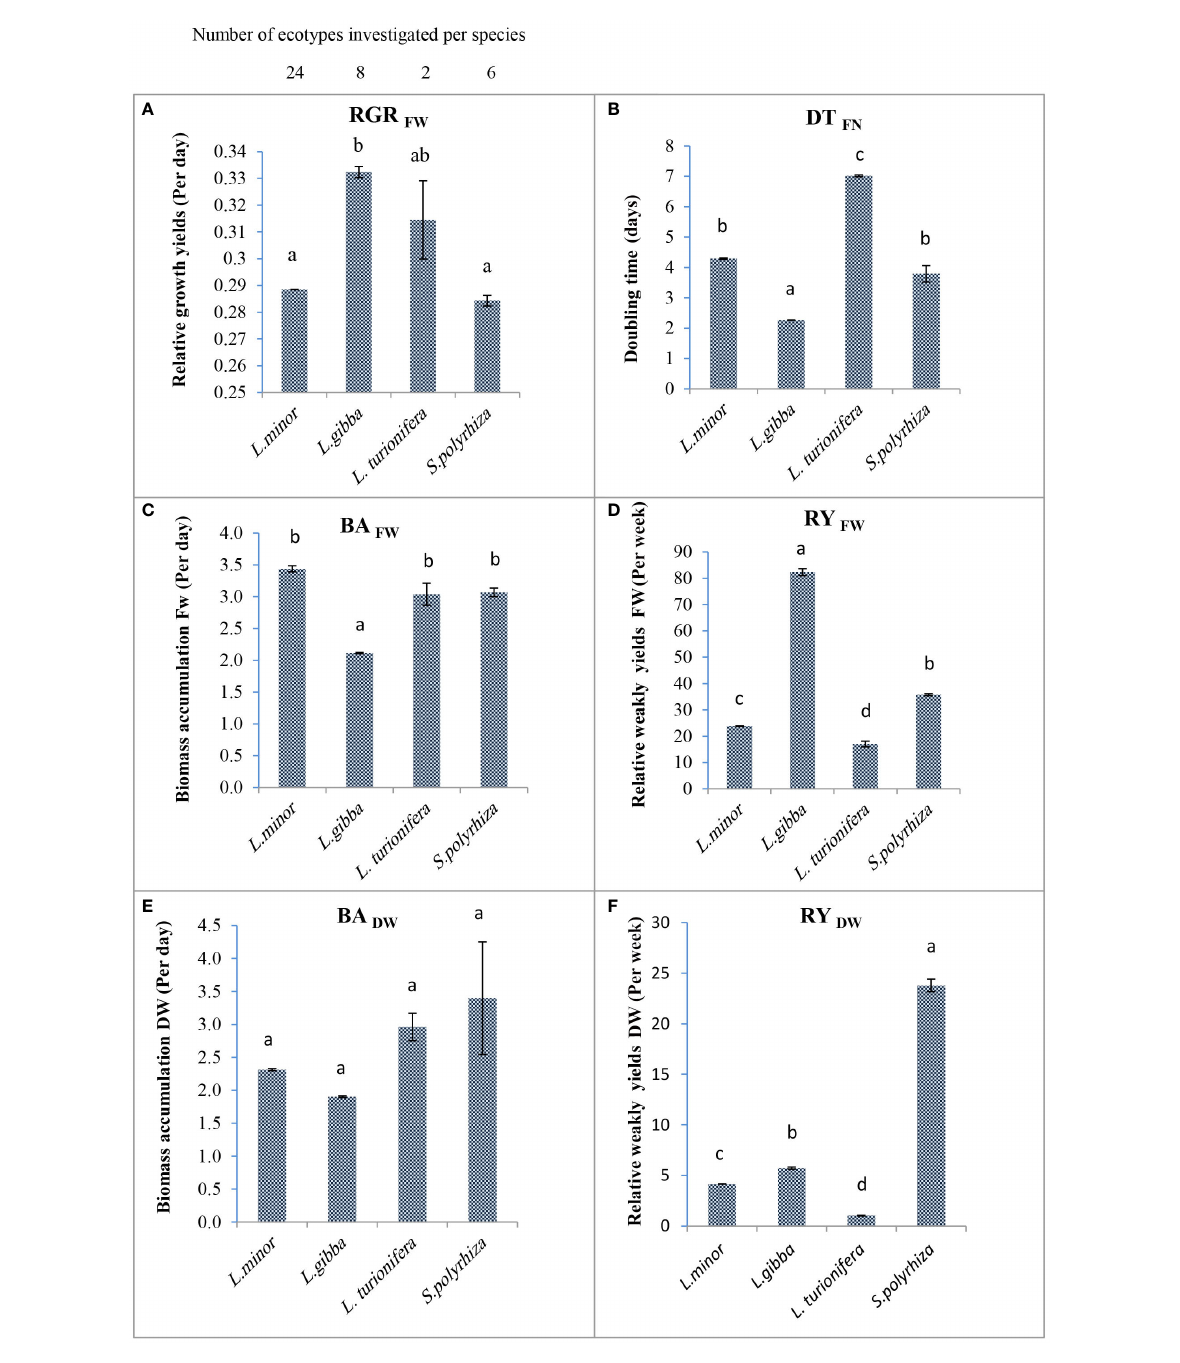
FIGURE 4 The mean fresh and dry weight – based relative growth rate (biomass accumulation, relative weekly yield, and doubling time based on frond number) of the four investigated duckweed species. (A) The mean RGR for the species represented by several clones. The number of clones per species is given above. (B) The mean value of DT FN between species is signi fi cantly different. Lemna gibba by doubling its fronds every 2.26 days is faster than other species. (C) The mean BA FW of four species of two genera is shown. (D) The maximum rate of mean RY FW of four species belongs to L. gibba (82.3 per week). (E) The mean of BA DW is not signi fi cantly different among species. (F) The mean dry weight (mg) produced after 1 week (RY) from primary inoculum among species is signi fi cantly different ( P <.05). In all fi gures: The column height shows the mean growth parameters of the four investigated species. Error bar was indicated in the fi gures. Letters above the columns indicate signi fi cance according to ANOVA: means of columns marked with the same letter (either ‘ a ’ or ‘ b ’ ) do not differ to a statistically signi fi cant extent; differences are statistically signi fi cant when the columns are marked with single, different letters. The means of the columns marked with ‘ ab ’ do not differ signi fi cantly from means of columns marked with either ‘ a ’ or ‘ b ’